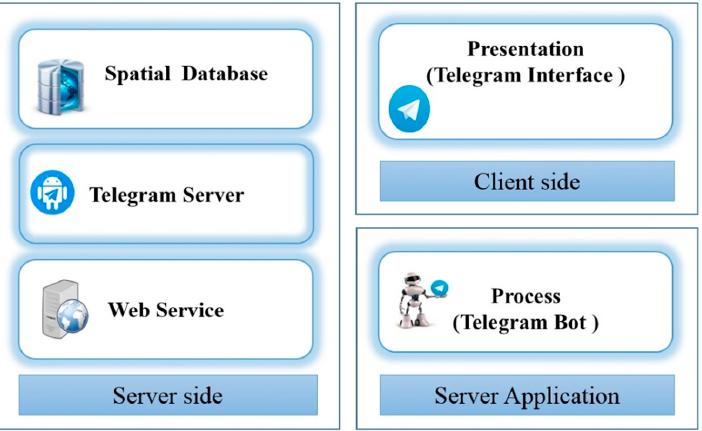
Figure 5. System architecture for the decision of urban services.